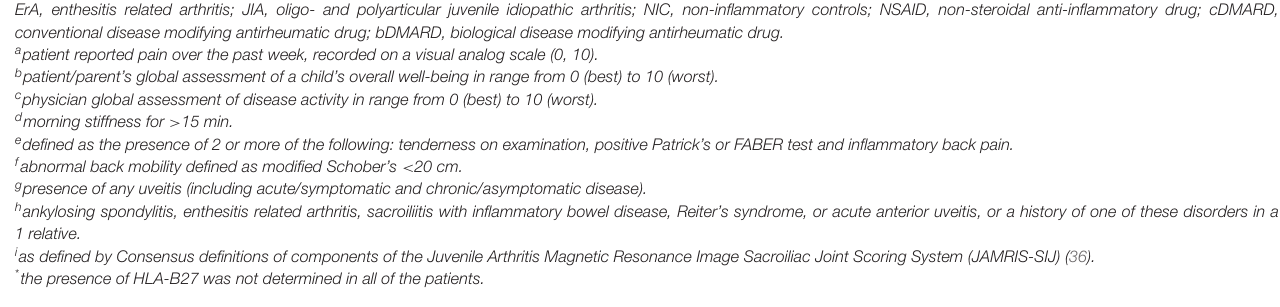
1 relative. i as defined by Consensus definitions of components of the Juvenile Arthritis Magnetic Resonance Image Sacroiliac Joint Scoring System (JAMRIS-SIJ) (36). * the presence of HLA-B27 was not determined in all of the patients.